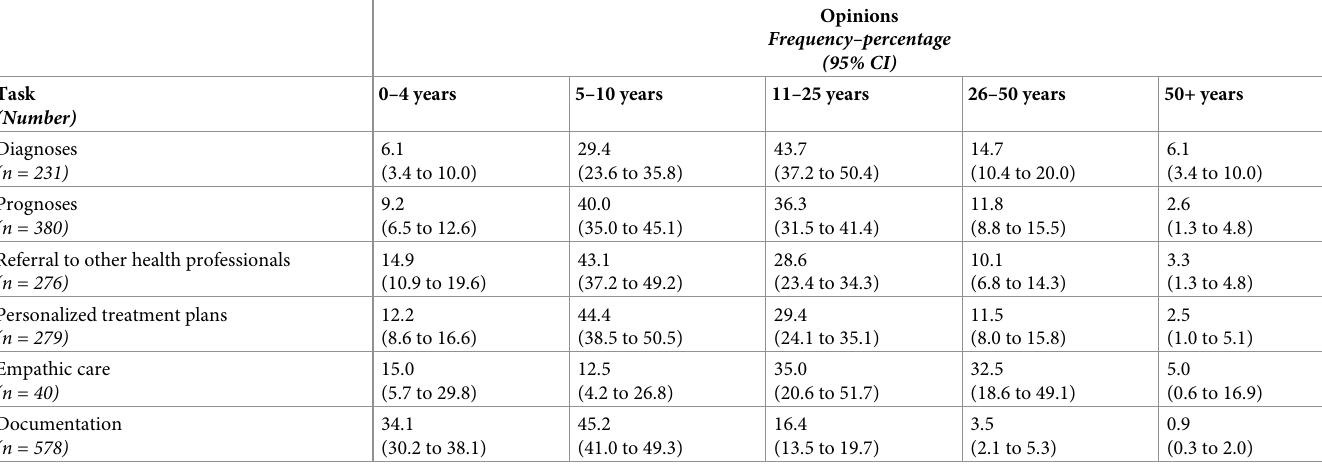
Table 3. Opinions about timescale for technological capacity to emerge �